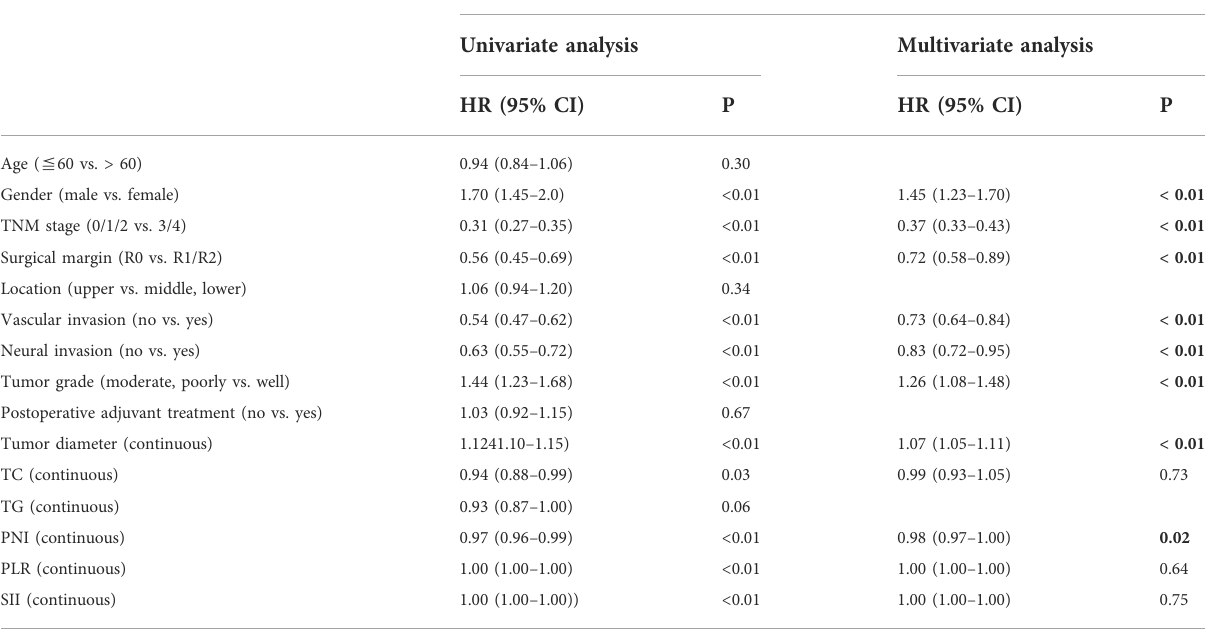
TABLE 2 Univariate and multivariate analysis of overall survival in the overall cohort. Variables Overall cohort ( n =